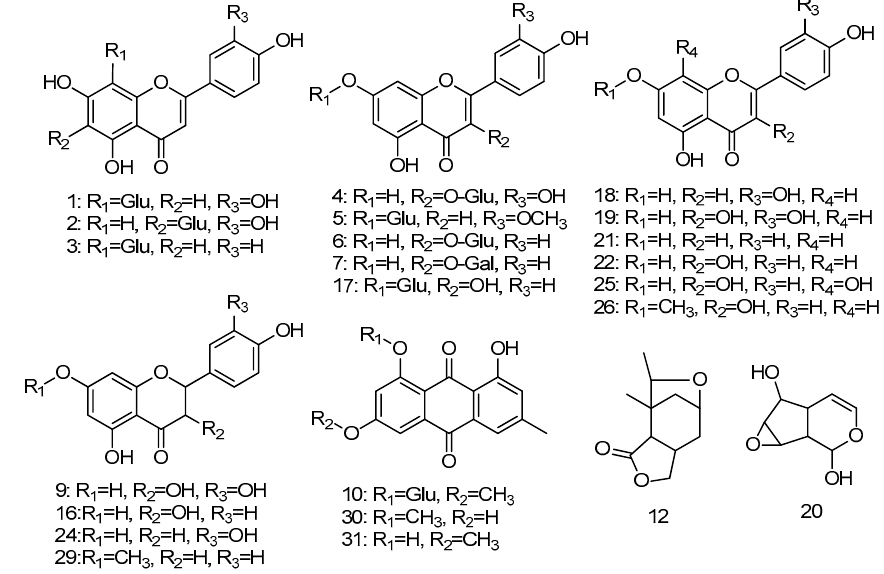
Figure 2. The chemical structures present in R. davurica . The peak numbers in this figure correspond to those used in Table 1.